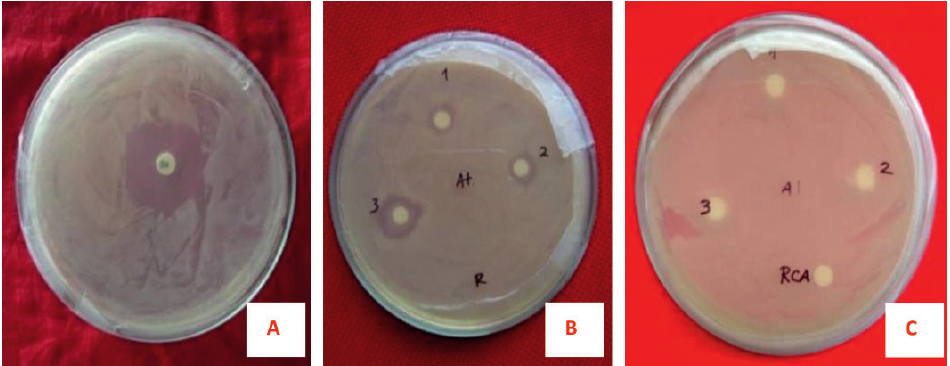
Fig. 2. Antimicrobial activities of drug discs against Staphylococcus aureus . (A) Kanamycin, (B) Allium sativum extract, (C) Rhizobium from Cicer arietinum .